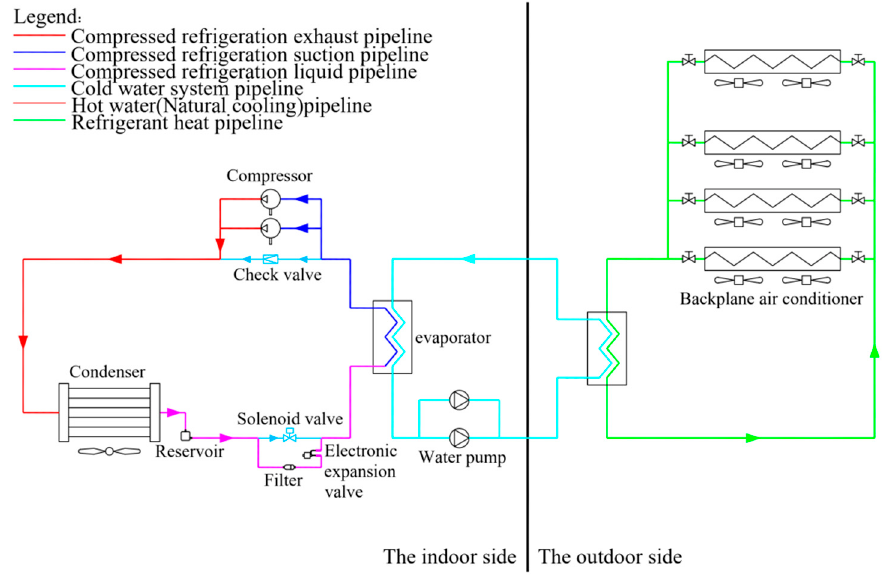
Figure 1. Backplane heat pipe air conditioning system.